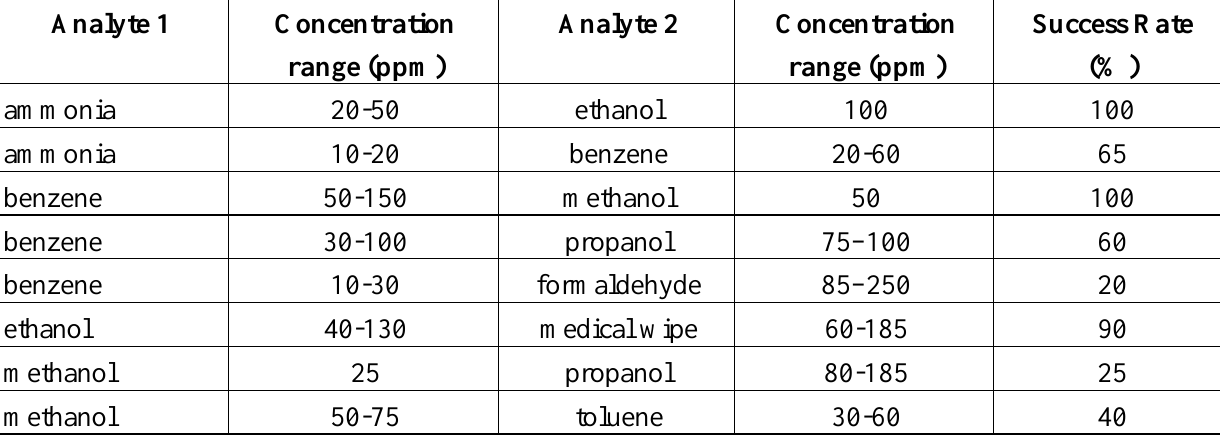
Table 2. Success rates of identifying and quantifying both analytes in binary mixtures of